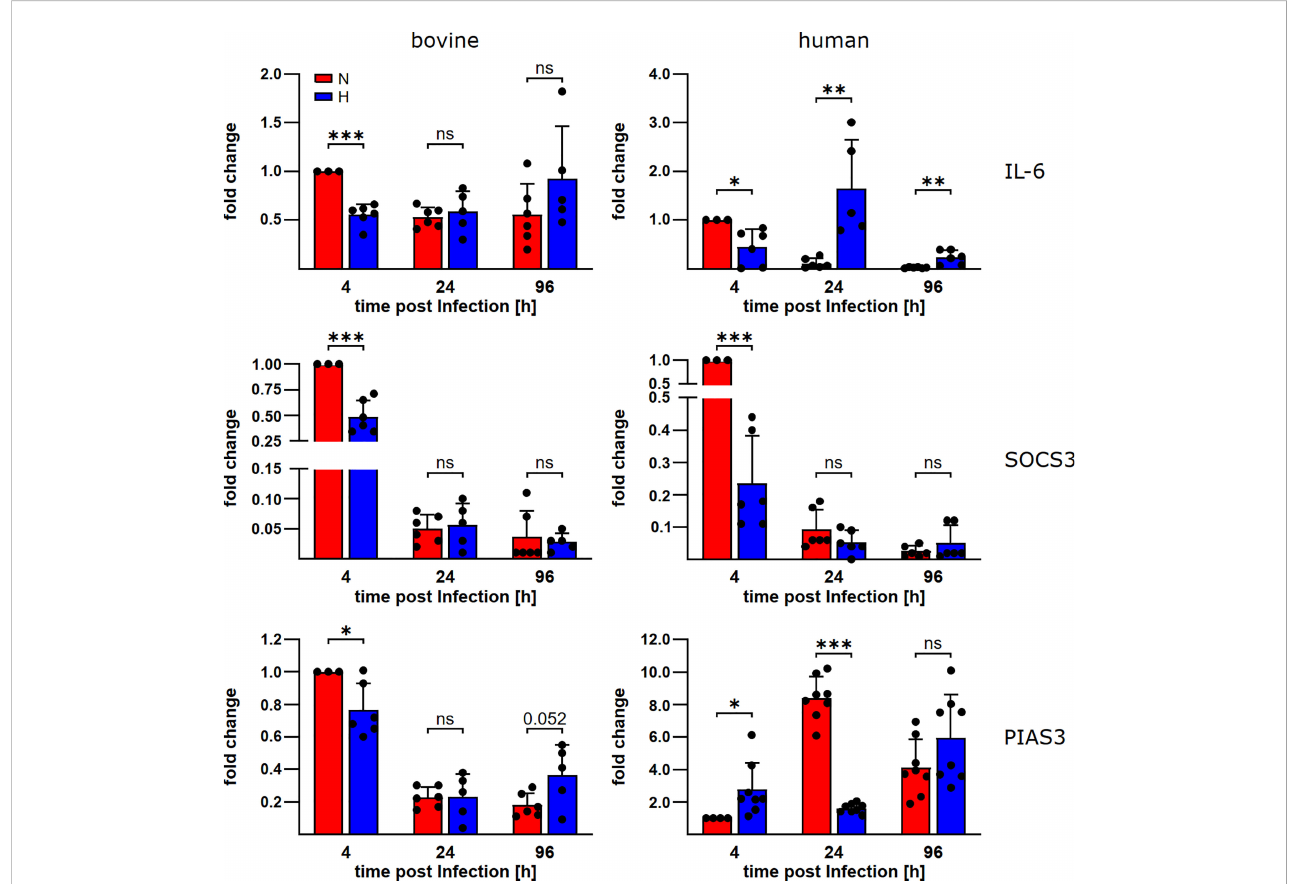
FIGURE 5 C. burnetii -infection in fl uences gene expression of STAT3 regulators. Gene expression was determined for the genes encoding IL-6, SOCS3 and PIAS3 in C. burnetii NMII infected normoxic and hypoxic bovine (left) and human (right) macrophages at the time points indicated. The data from three to four independent experiments are shown as mean ± SD of 2^- DD CT values (using human or bovine HPRT as a calibrator). Fold changes are shown relative to the 4 h time point under N. One-sample t-test, unpaired t-test or Mann-Whitney test, n=5-6 (bovine) and n=6-8 (human) ***p<0.001, **p<0.01, *p<0.05,